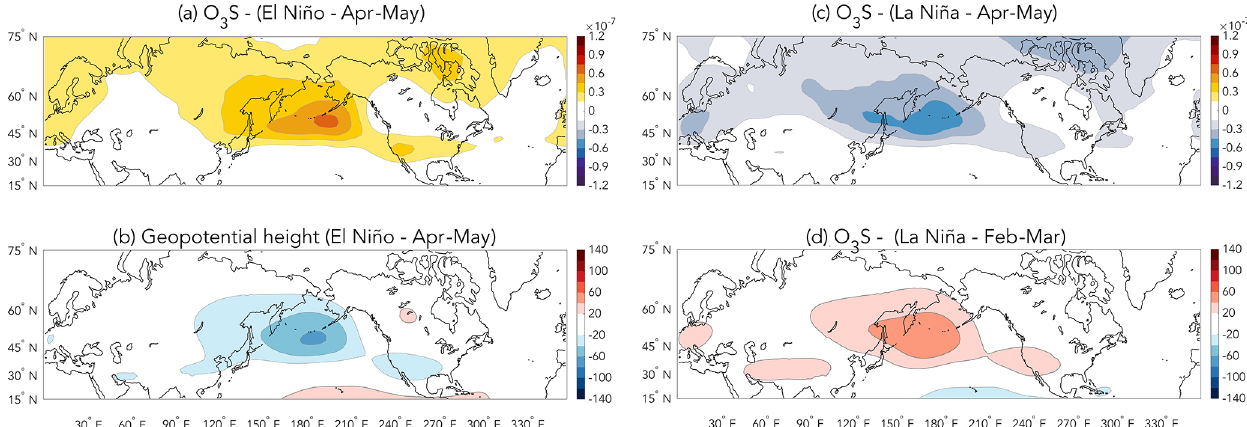
Figure 6. April–May (200hPa pressure level) anomaly composites of O 3 S (units: mass mixing ratio) for (a) El Niño and (b) La Niña and geopotential height (units: gpm) for (c) El Niño and (d) La Niña.